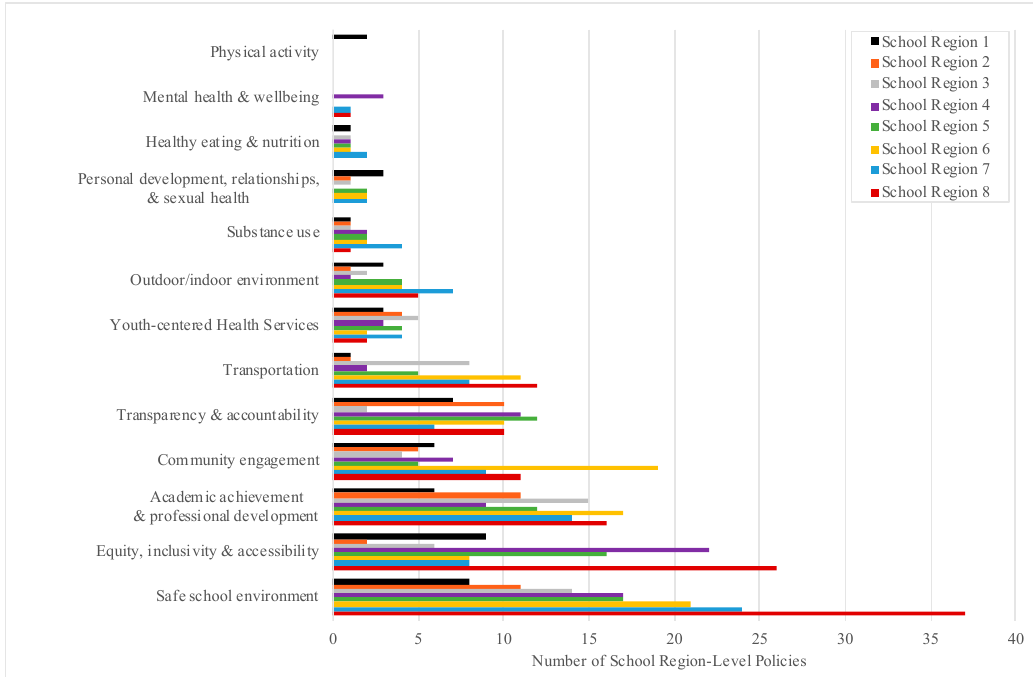
Figure 4. Number of Current Nova Scotia School Region-Level Policies According to Health Promotion Topic. The absolute number of existing policies corresponding to each health promotion topic was examined across eight individual school regions in the province.